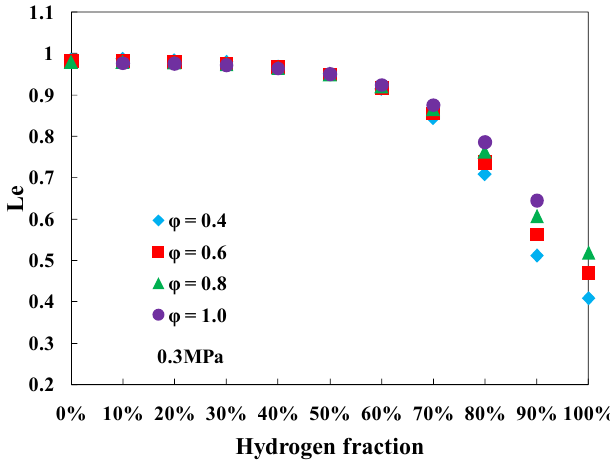
Figure 8. Lewis number plotted against hydrogen fraction.